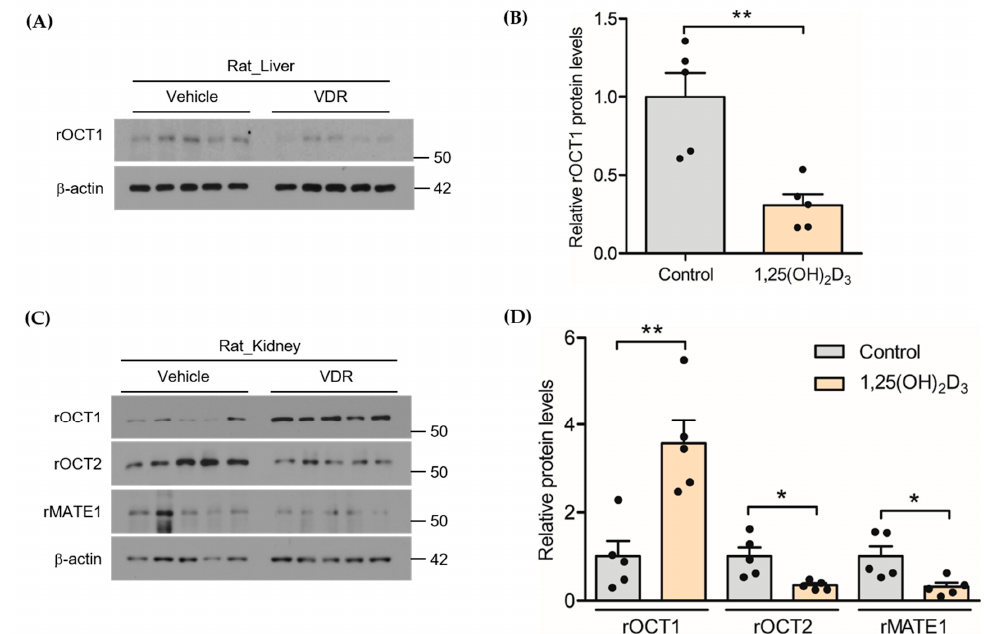
Figure 2. Effects of 1,25(OH) 2 D 3 on the protein expression levels of hepatic rOCT1 and renal rOCT1, rOCT2, and rMATE1. ( A ) Western blotting for hepatic rOCT1, ( B ) densitometry of western blotting for hepatic rOCT1 ( C ) Western blotting for renal rOCT1, rOCT2, and rMATE1, ( D ) densitometry of western blotting for renal rOCT1, rOCT2, and rMATE1 in control and 1,25(OH) 2 D 3- treated groups ( n = 5 each group). ** Indicates p < 0.01 and * indicates p < 0.05.